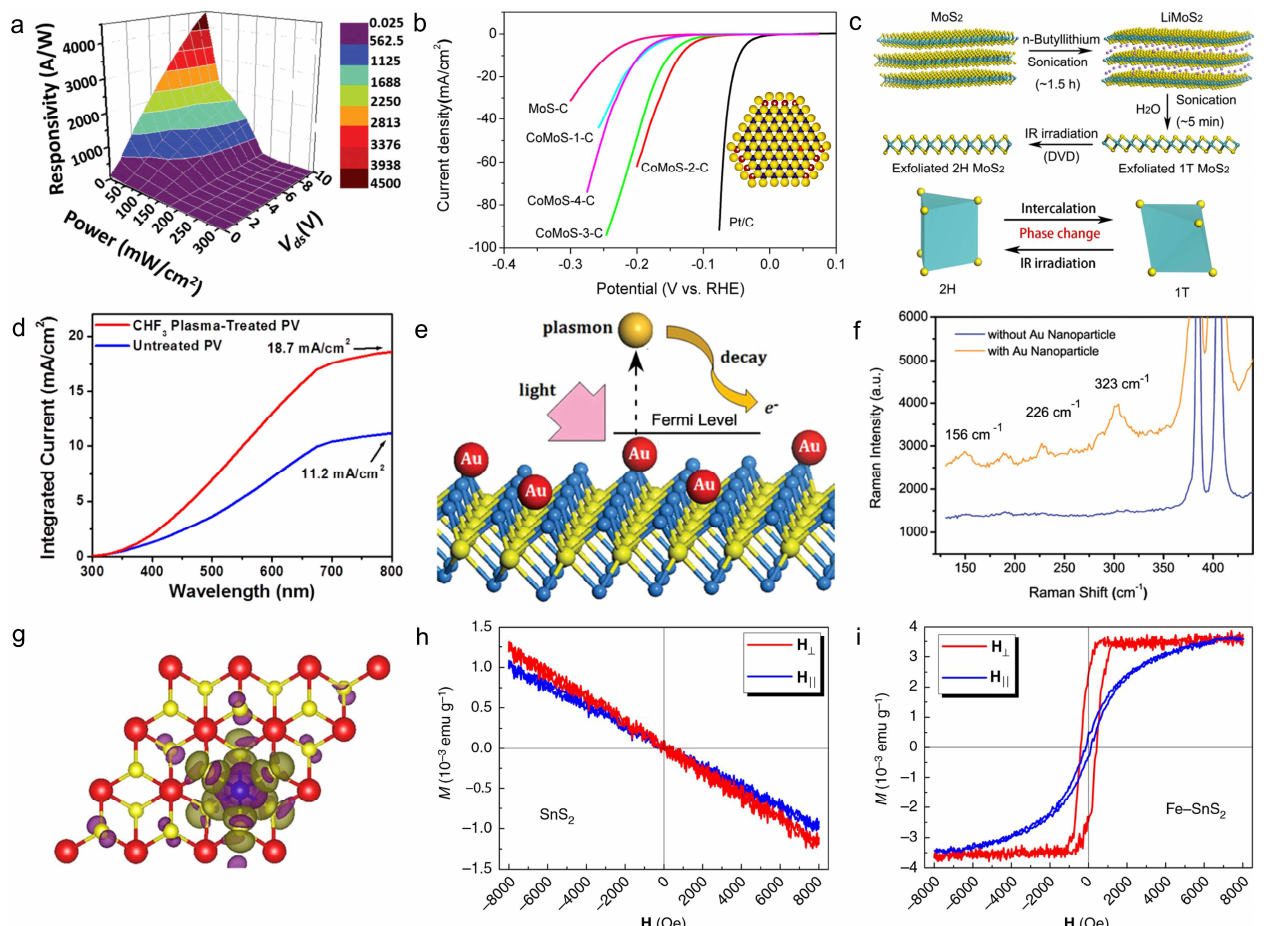
Figure 7. Optoelectronics, catalysis, and magnetism of 2D doped materials. ( a ) Three-dimensional view of photoresponsivity mapping of few-layered SnSSe phototransistor. Reproduced with per- mission from [44]. ( b ) Polarization curves of various Co/Mo ratios and calcination temperatures. Reproduced with permission from [113]. ( c ) Reaction schematic for the preparation of exfoliated 2H MoS 2 . Reproduced with permission from [114]. ( d ) The curve of the integral of the overlap between these measured EQE values and the standard AM1.5G spectrum over a wavelength range of 300–800 nm. Reproduced with permission from [118]. ( e ) The principle of hot electron generation. ( f ) Raman spectra of MoS 2 before and after the Au NP deposition and illumination. Reproduced with permission from [118]. ( g ) The distribution of the spin density for the Fe-SnS 2 monolayer. ( h , i ) Magnetic hysteresis loops for SnS 2 and Fe 0.021 Sn 0.979 S 2 at 2 K, respectively. Reproduced with permission from [92].